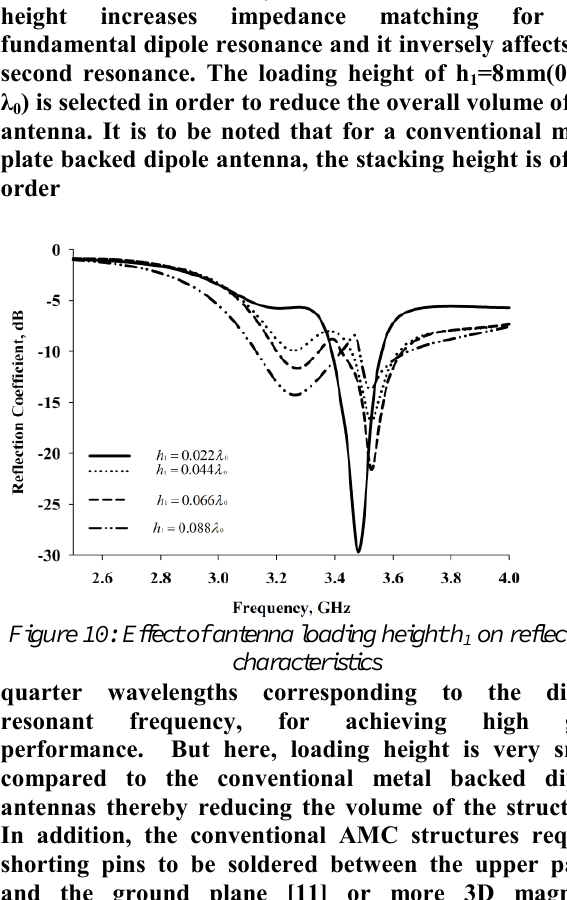
on reflection 1